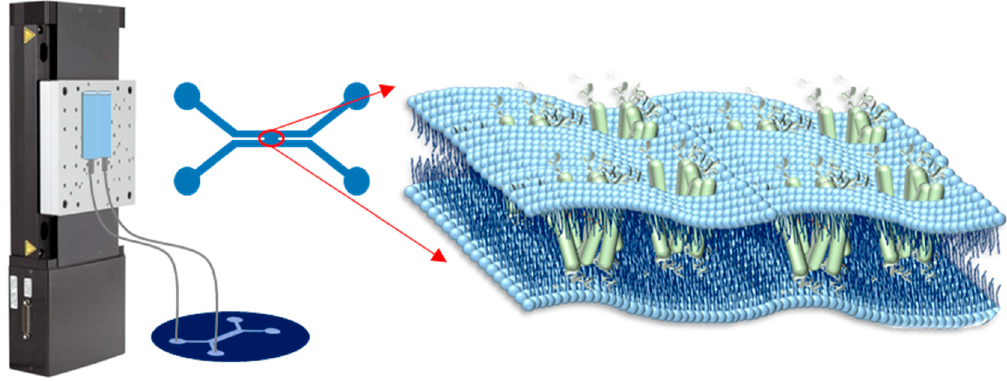
Figure 4. Design and structure of the microfluidic setup including the hydrostatic pressure system.